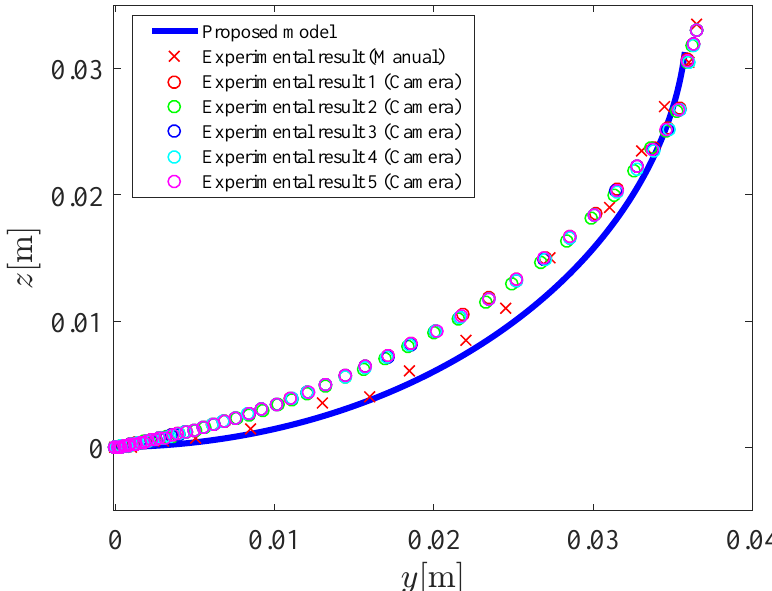
Figure 12. The coordinate values y and z of the tip of the micro-hand ( P 1 = P 3 = 0kPa, P 2 = 0 kPa–250